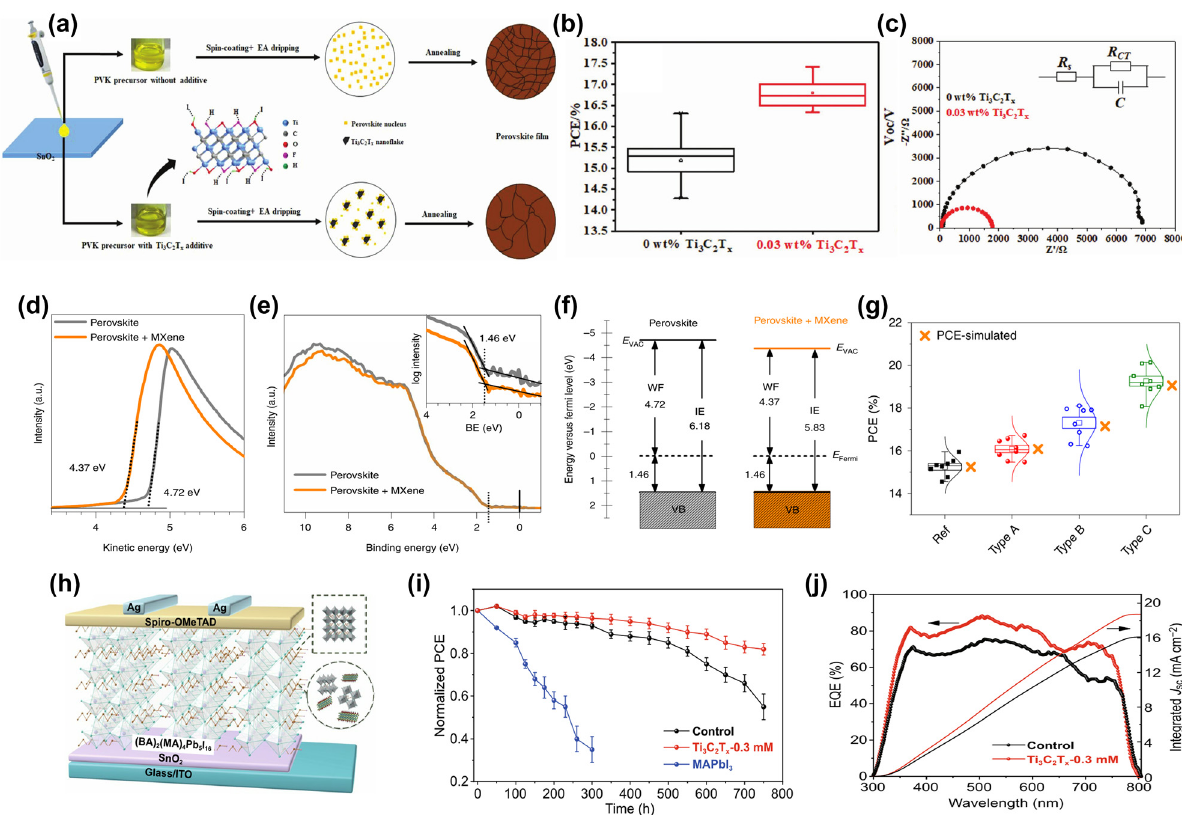
Figure 10: The preparation process and properties of MXene composites for perovskite solar cells. (a) Proposed nucleation and growth route of perovskite film with and without Ti C T . (c) Nyquist plots of 0 and 0.03 wt% Ti without 0.03 wt.% Ti 3 2 x Reproduced with permission [169]. Copyright 2018, Wiley-VCH. UPS curves of pristine and MXene-doped perovskite films. (d)UPS spectra around the secondary electron cut-off. (e) UPS spectra in the valence band (VB) region. (f) Energy scheme for undoped and MXene-doped perovskite with respect to the EFermi. IE, ionization energy. EVAC, vacuum level. BE, binding energy. (g) Photovoltaic parameter statistics of PCE for the investigated PSCs. Reproduced with permission [170]. Copyright 2019, Springer Nature. (h) Schematic diagram of devices with /2D perovskite/Spiro-OMeTAD/Ag. (i) Stability of MAPbI the structure of Glass/ITO/SnO 2 without sealing at air atmosphere with humidity of 55 ± 5%. (j) EQE spectra and integrated Jsc of the control and optimized Ti devices. Reproduced with permission [171]. Copyright 2021, Springer